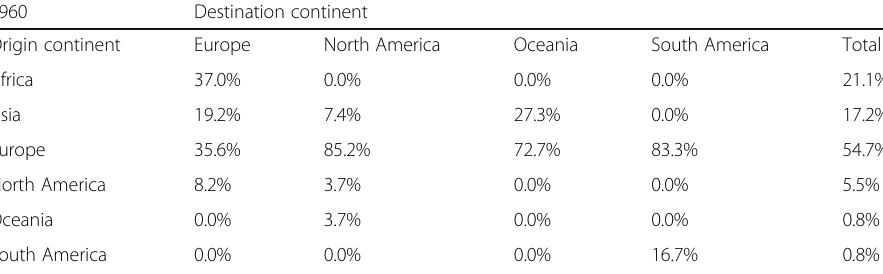
Table 3 Cross-continental movements of foreign-born Olympic athletes